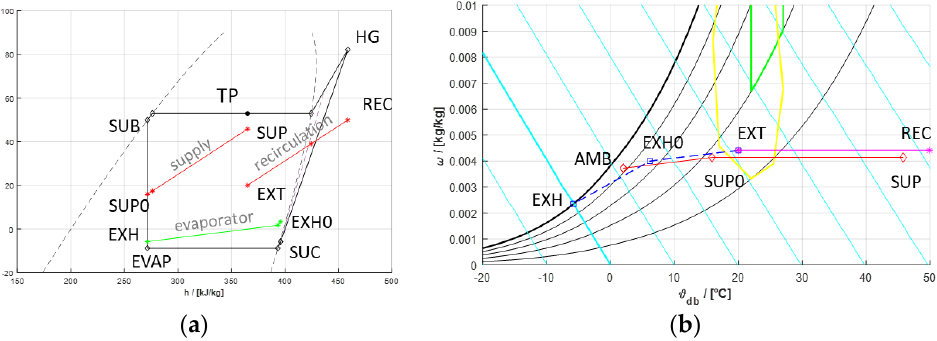
Figure 6. ( a ) Temperature-enthalpy-diagram of an exhaust air heat pump with two condensers (R134a) and ERV and ( b ) corresponding psychrometric chart; SUP: supply air, EXT: extract air: REC: recirculation air; HG: hot gas out; SUB: subcooling; SUC: suction; TP: two phase.